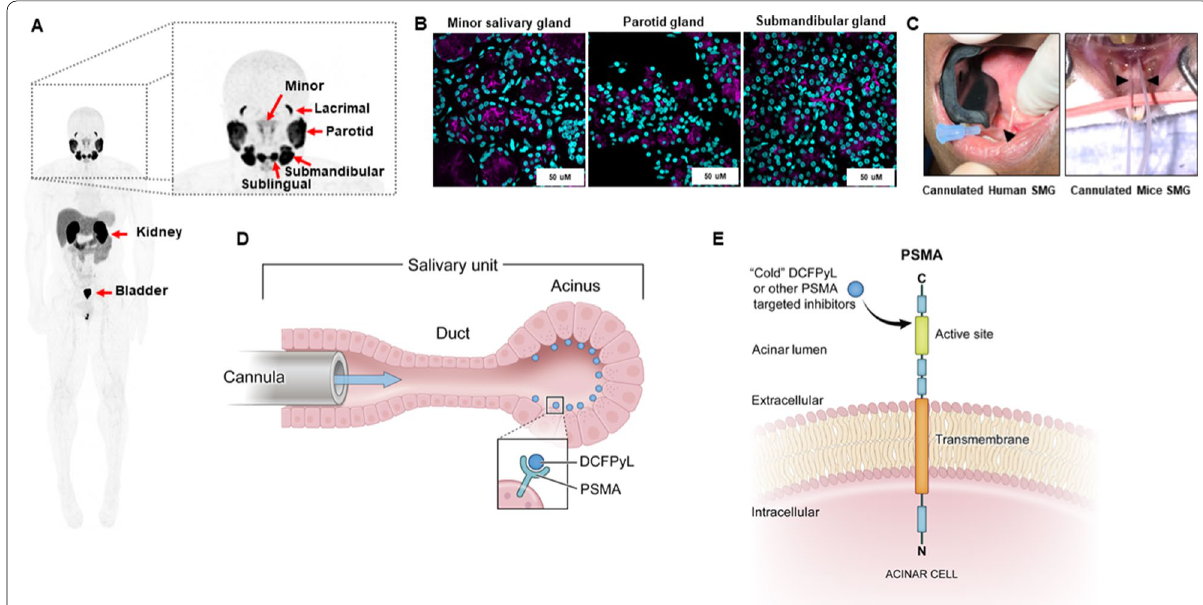
Fig. 1 a PET/CT scan of a patient administered with [ 18 F]DCFPyL demonstrating uptake in the bladder, kidney, salivary (parotid, sublingual, submandibular, and minor/seromucous glands), and lacrimal glands. b Immunofluorescence staining of PSMA in human salivary glands (magenta: anti-PSMA staining on the apical lumen of acinar cells; teal: DAPI nuclei staining). c Cannulated submandibular salivary glands (SMG) of mouse and human illustrating similarity in delivery of preventive therapy in our model system. Black arrowhead indicates the inserted cannula. d and e Diagram of the cannulation procedure showing how delivered cold DCFPyL can access and block PSMA sites on the acinar cell